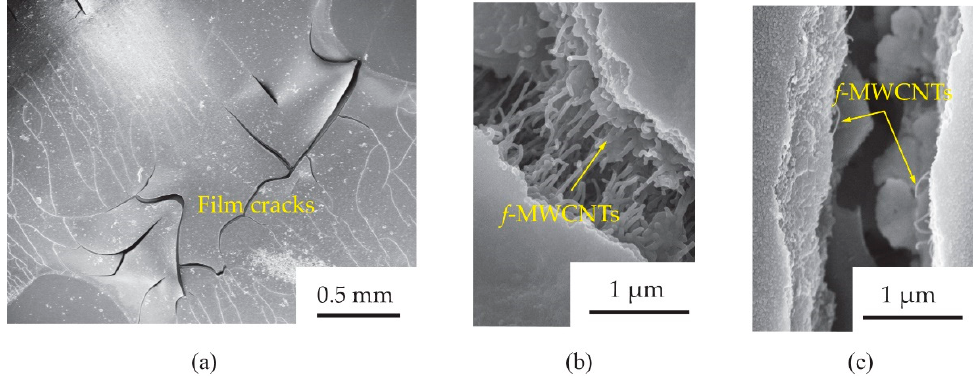
Figure 12. SEM images of ( a ) screen-printed f -MWCNT-PEDOT:PSS films (S3 sample) after bending tests with ( b ) 3.0 cm and ( c ) 0.9 cm radii.